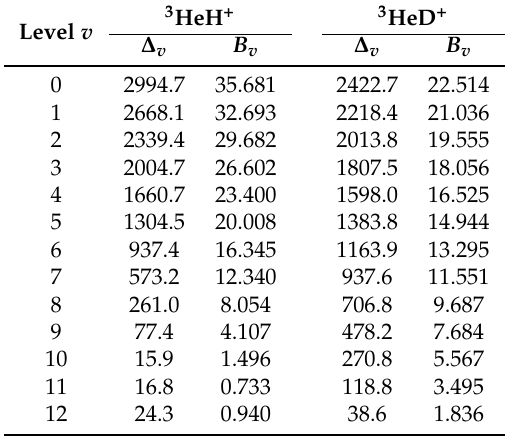
Table 2. Energies ∆ v = E v + 1 − E v for vibrational transitions v → v + 1 and rotational constants B v of the 3 HeH + and 3 HeD + molecules used in this study. All values are in cm − 1 . 3 HeH + 3 HeD Level v